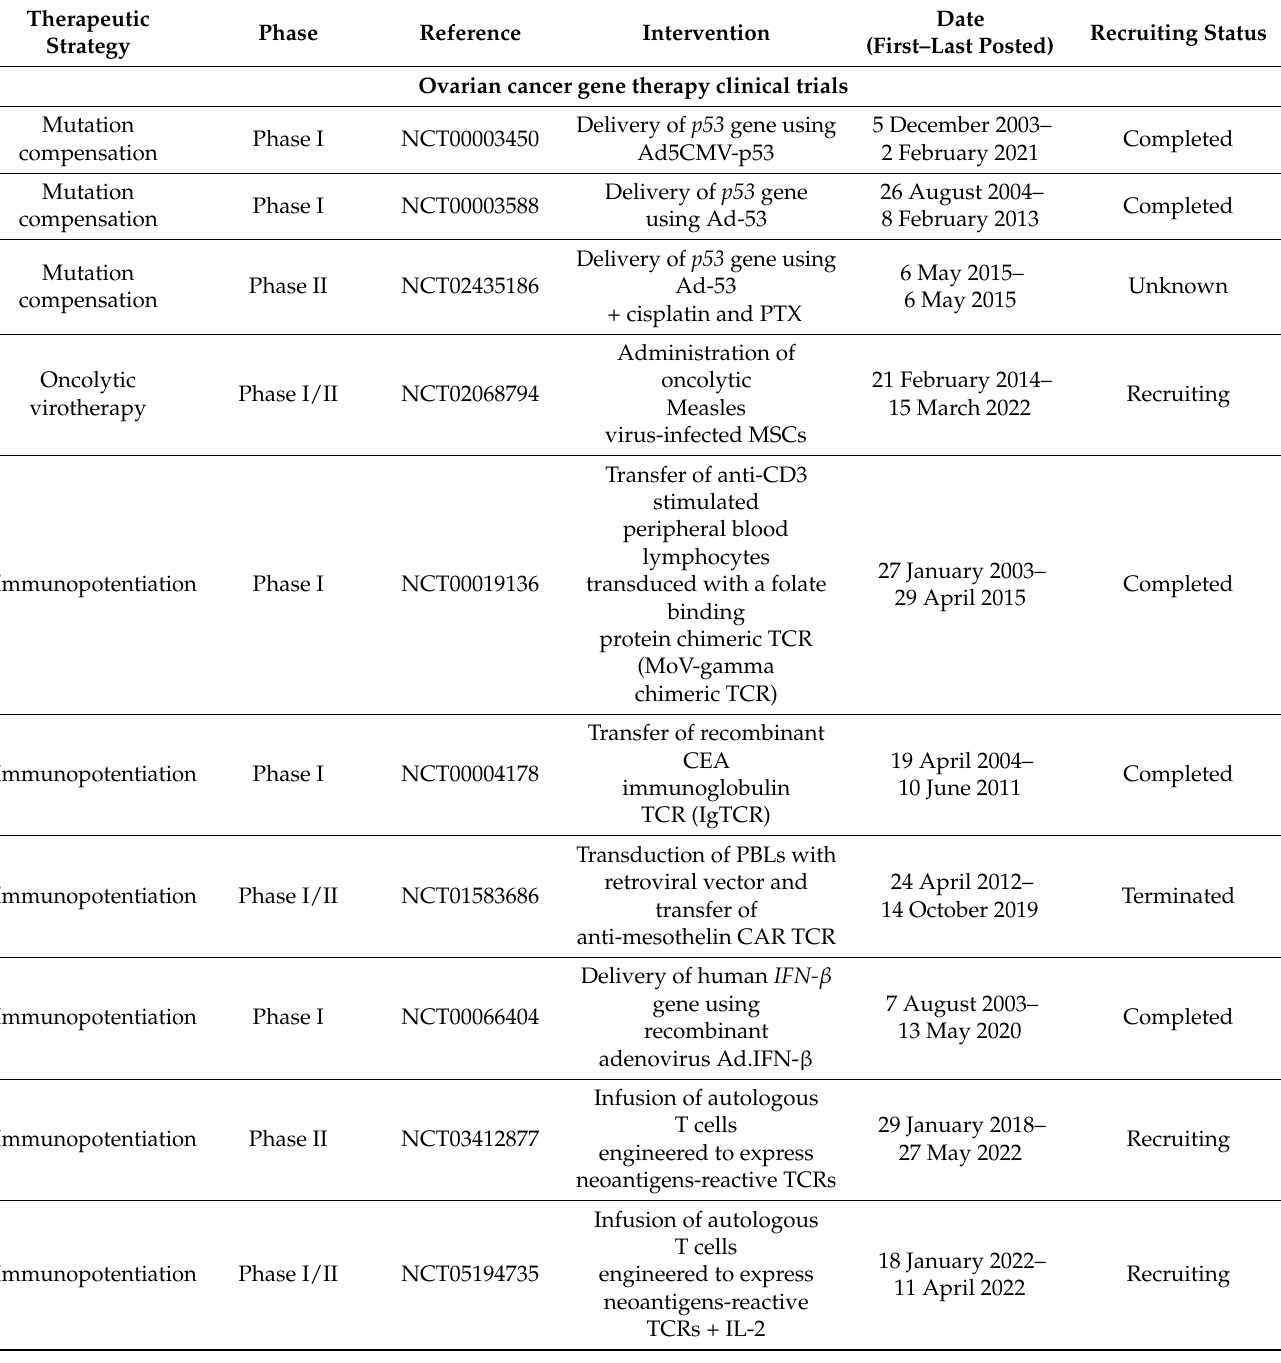
Table 4. Gene therapy clinical trials for ovarian, cervical and endometrial cancer available online clinicaltrials.gov (accessed on 29 May 2022)